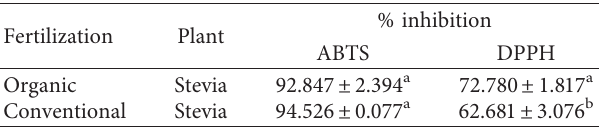
Table 3: Radical scavenging activity of stevia as a result of type of fertilization a .